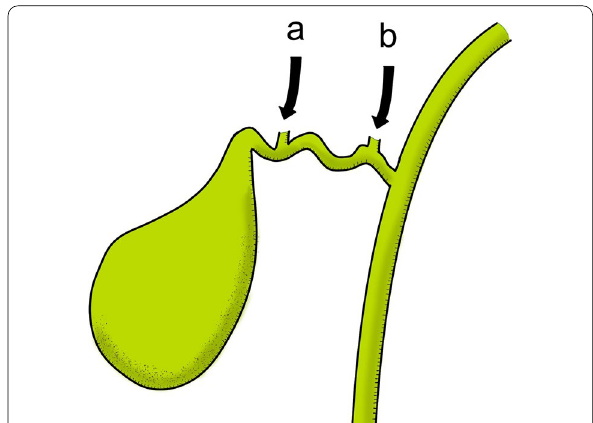
Fig. 4 A schema of the confluence pattern of the right hepatic duct on the cystic duct. There were two patterns of the confluence based on the previous four reports. Three out of four (75%) showed the right hepatic duct entering the distal side of the cystic duct (a). One out of four (25%) showed the right hepatic duct entering the proximal side of the cystic duct